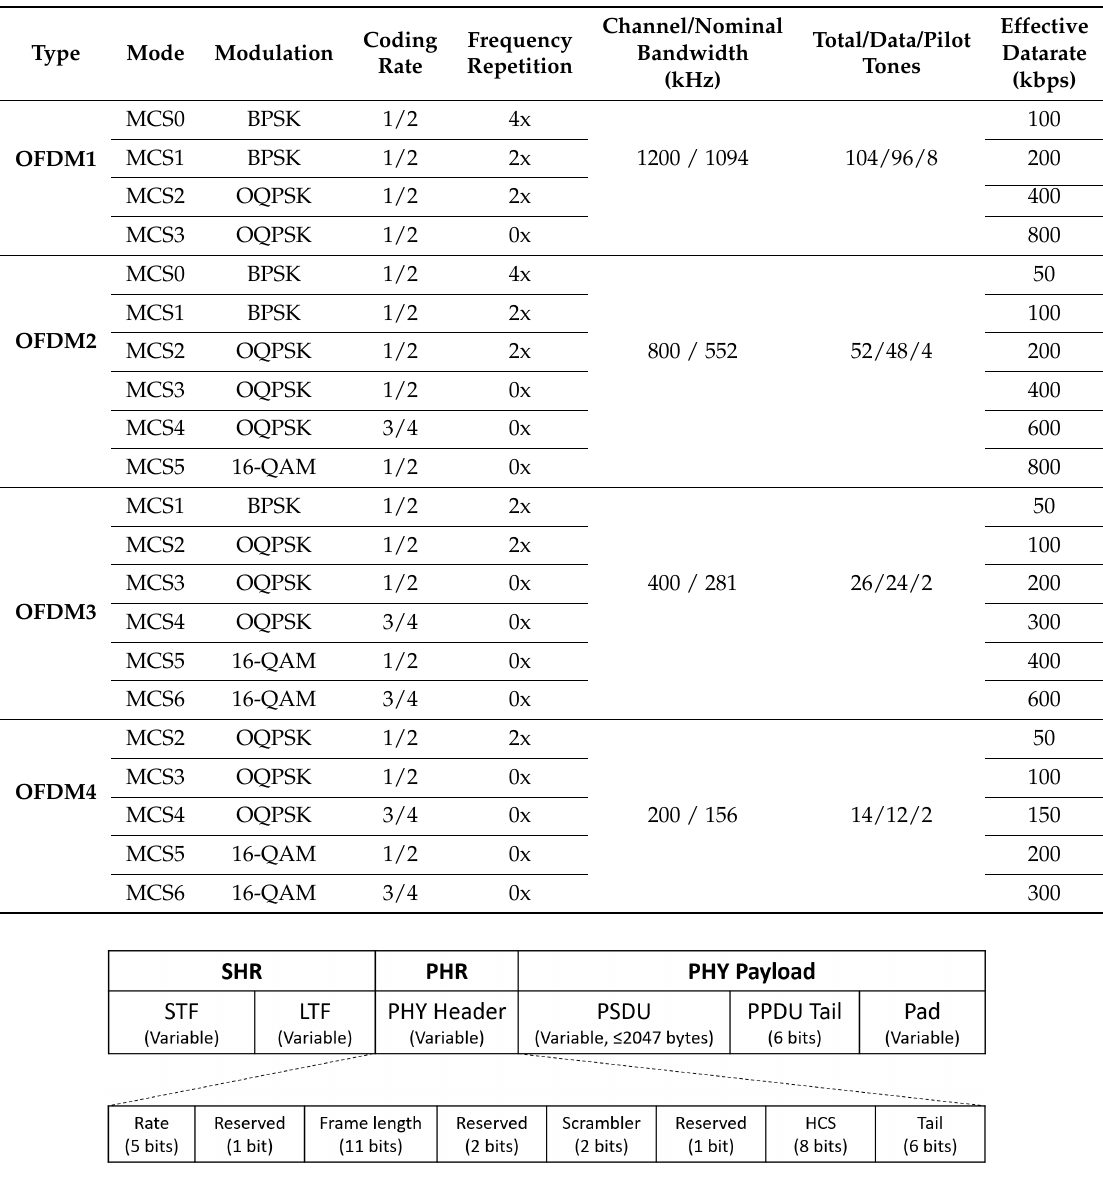
Figure 2. IEEE 802.15.4-2015 SUN-OFDM frame